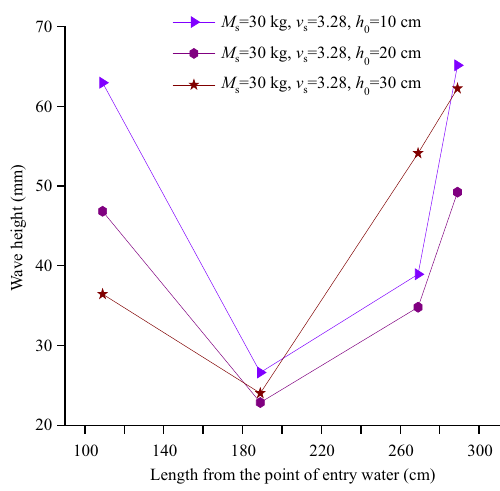
Fig. 4 Change in surge height with distance from the entry point